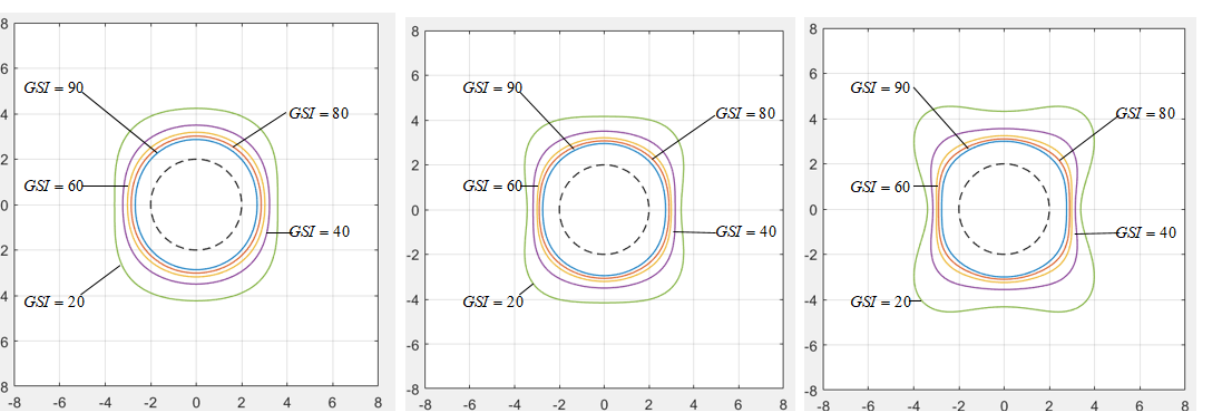
Figure 9. Plastic zone distribution of surrounding rock.